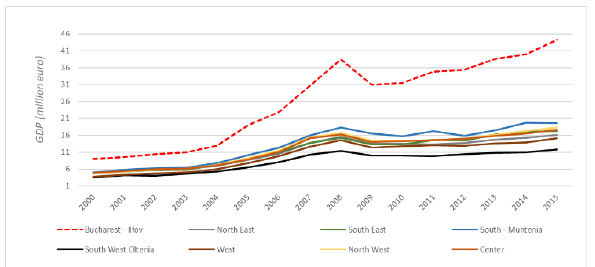
Figure 5 . Evolution of gross domestic product within the 8 development regions between 2000 and 2015 (data source: NIS 2022)